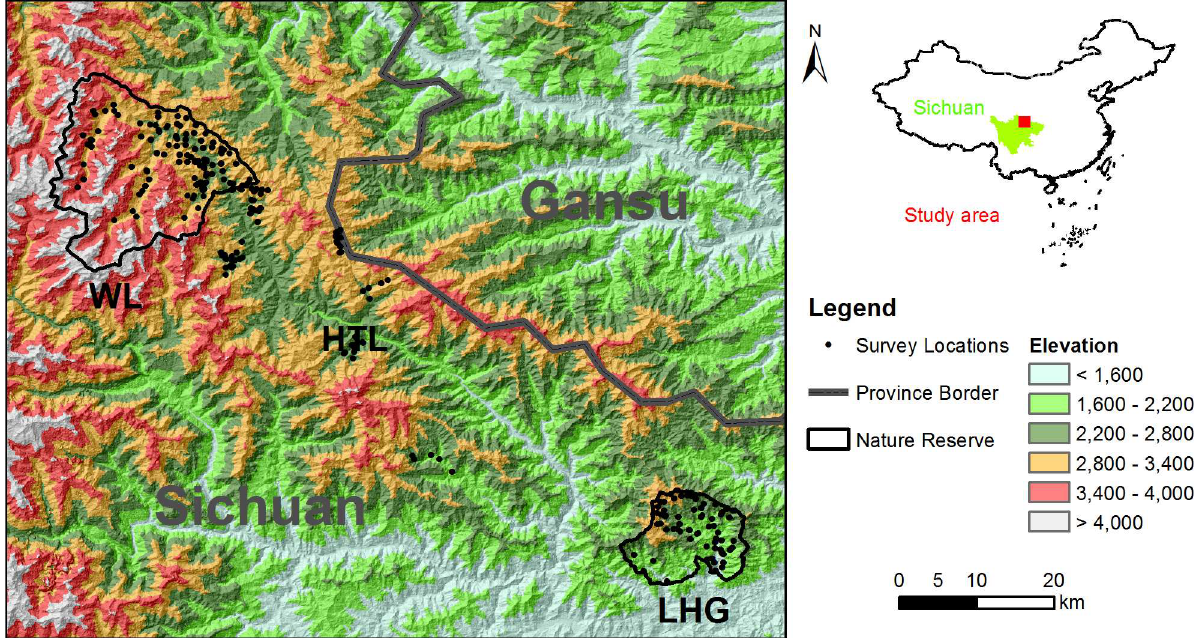
Fig 1. Study area and survey locations distributed in Minshan Mountains, Sichuan, China. The area includes 2 nature reserves (WL and LHG), and the unprotected area connecting established reserves (HTL, a proposed landscapecorridor for giant